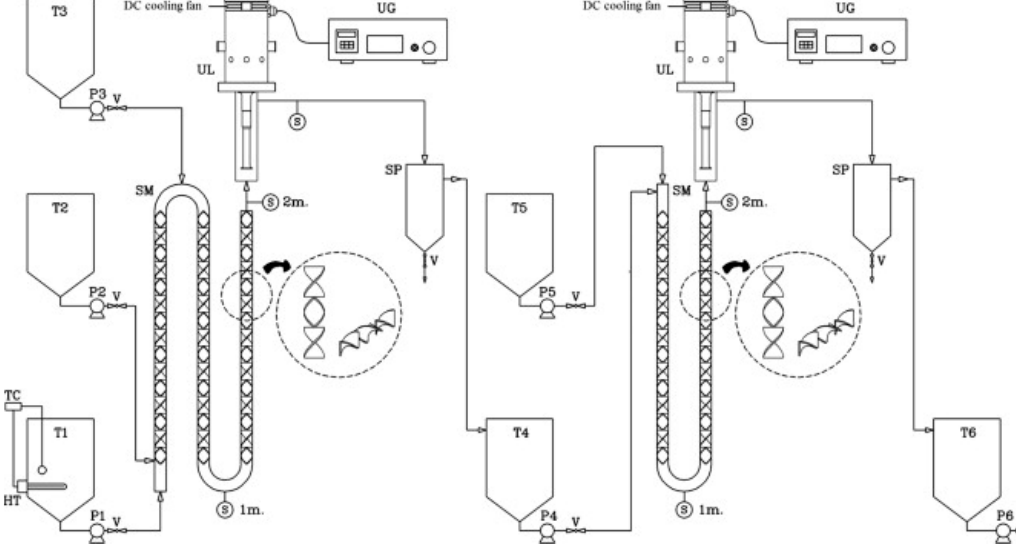
Figure 4. Two-stage continuous process to produce methyl esters from high FFA mixed crude palm oil using a static mixer coupled with high-intensity US